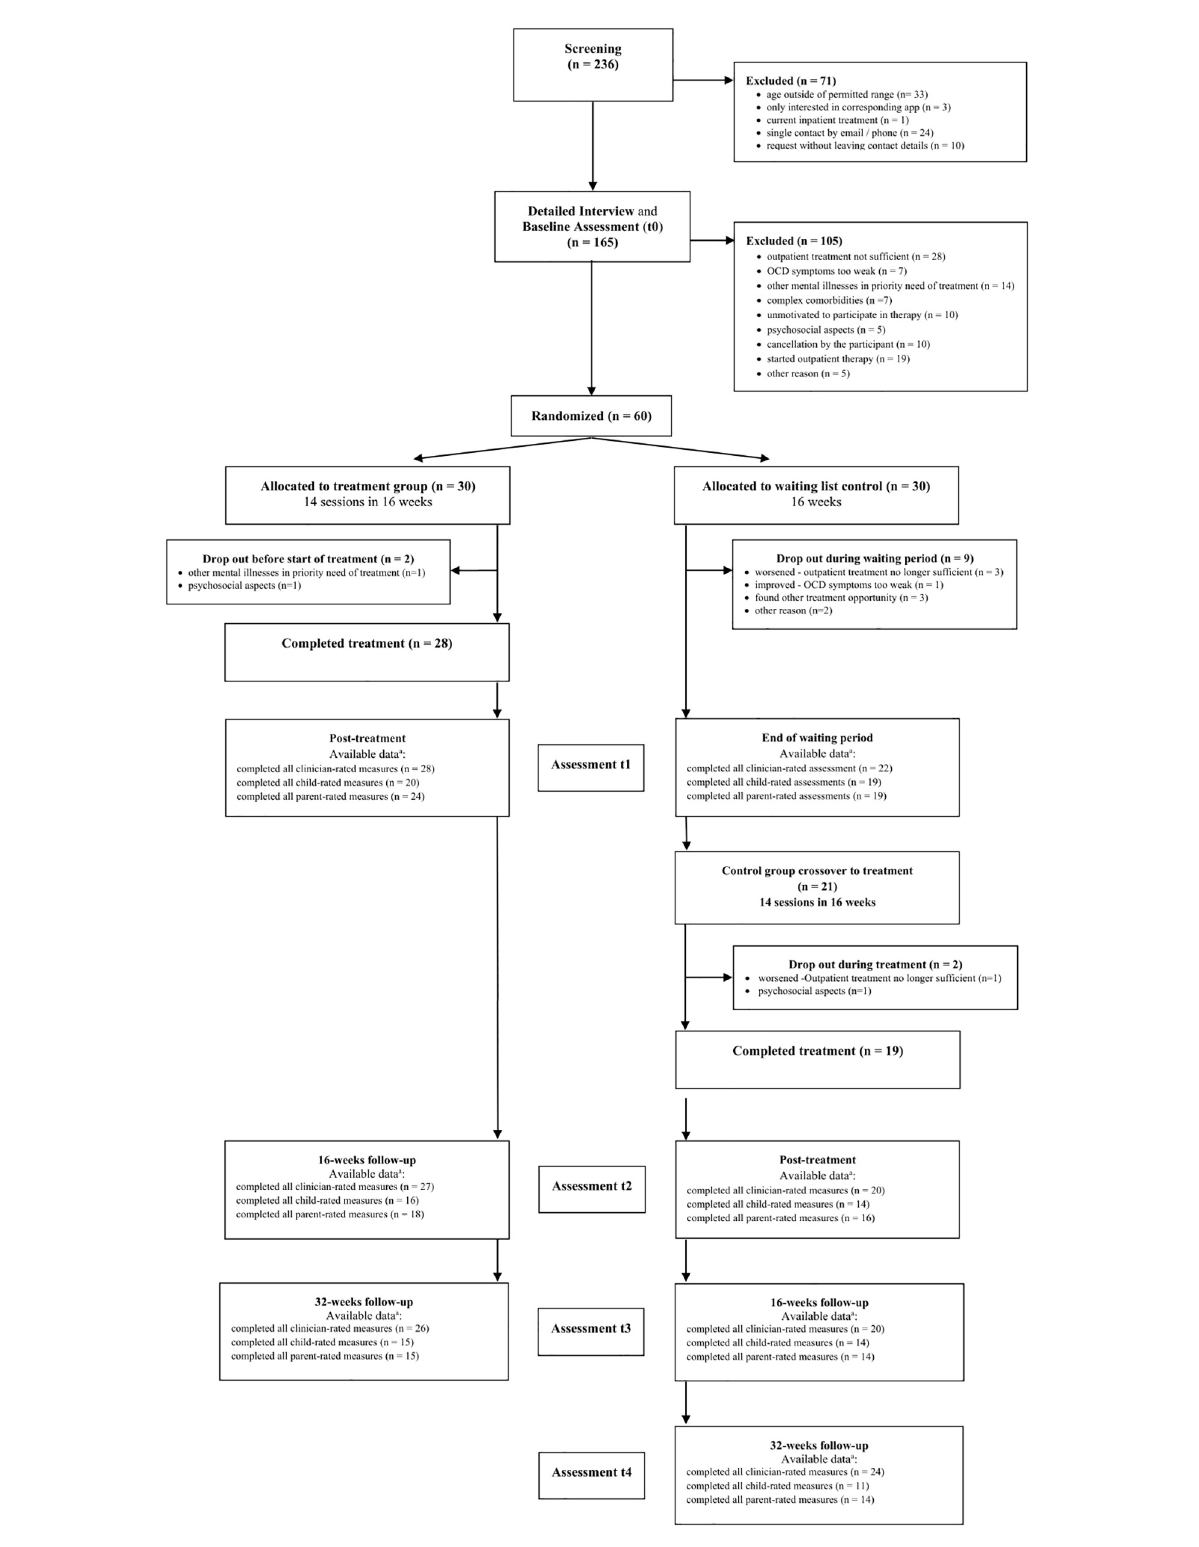
FIGURE1 Study flow chart. Listed as available data a are all data available at that measurement point, regardless of whether participants received treatment or not.